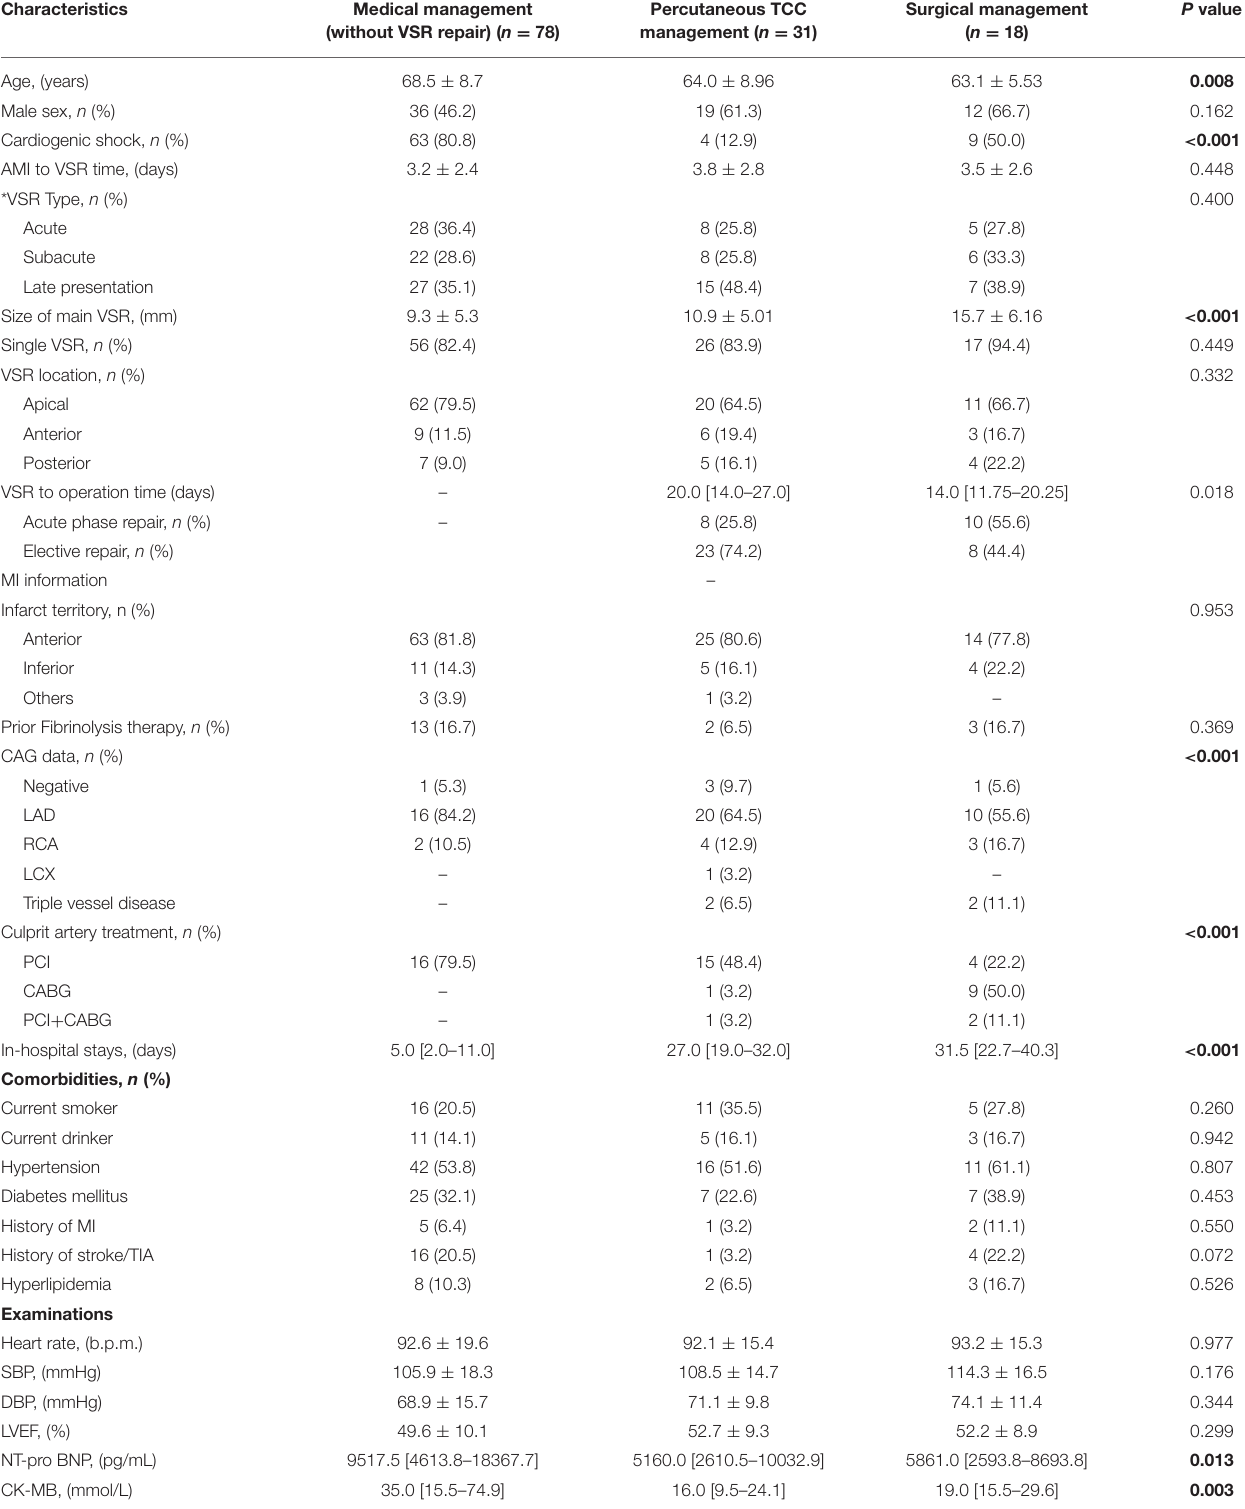
TABLE 1 | Characteristics of VSR patients stratified by different managements.